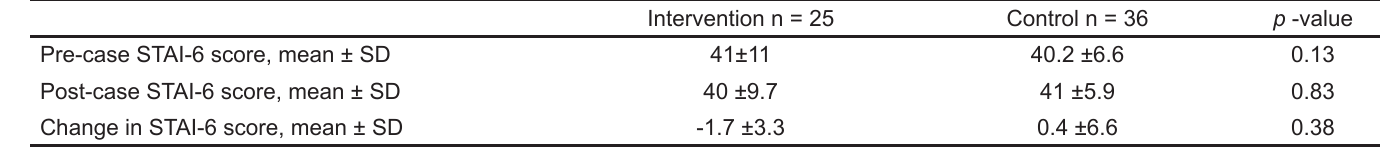
Table 2. Comparisons of mean State-Trait Anxiety Inventory-6 scores between control and intervention